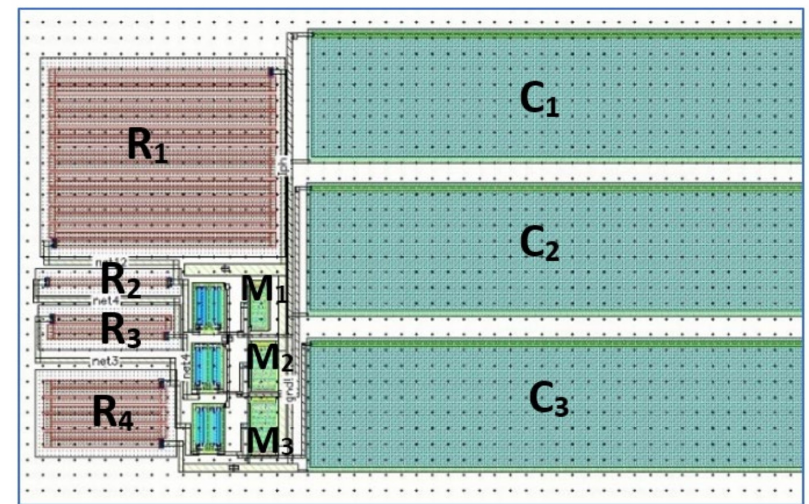
Figure 6. The proposed photocurrent sensory circuit